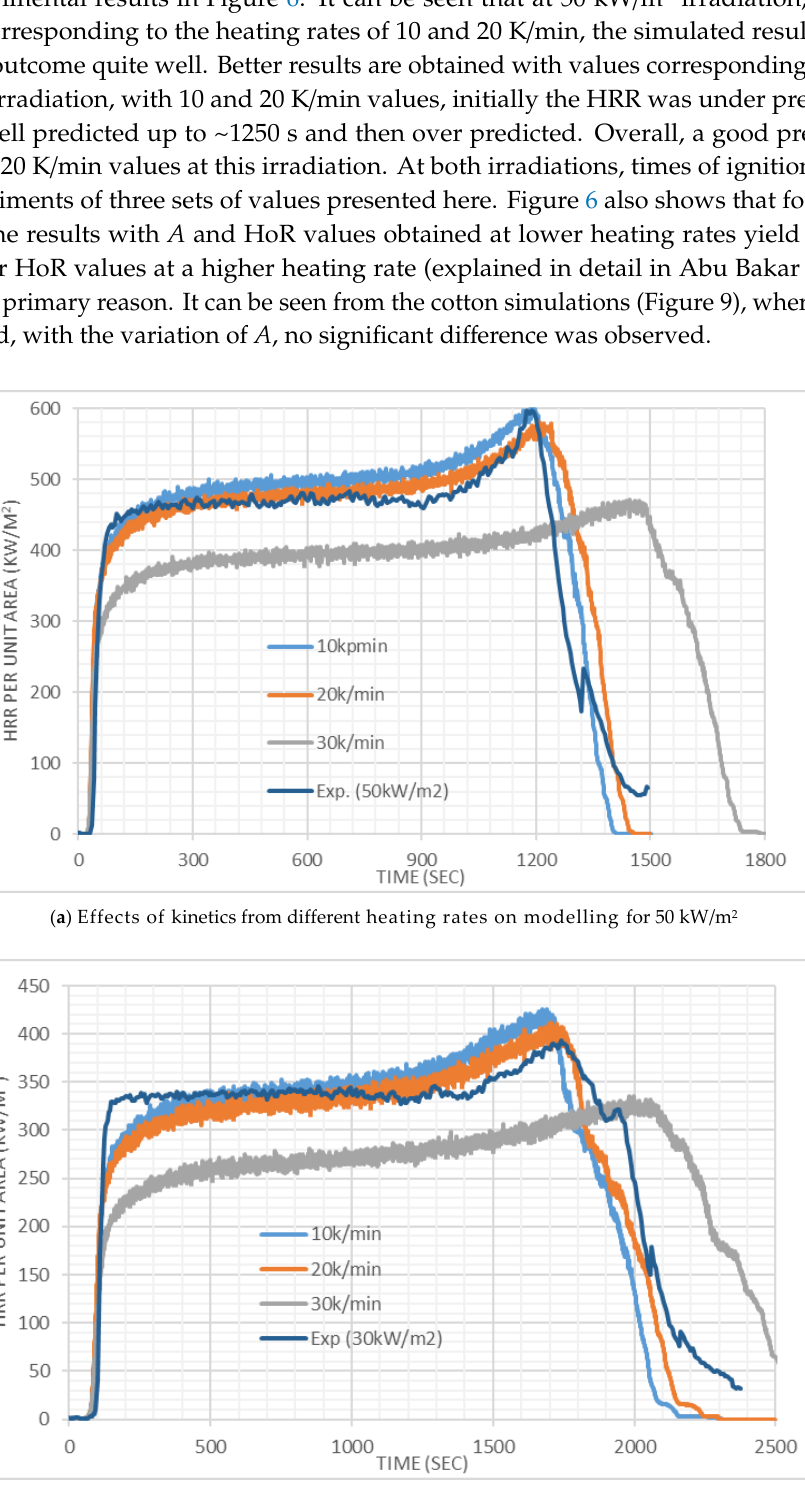
Figure 6. Heat release rate results for the cone calorimeter tests with PMMA.